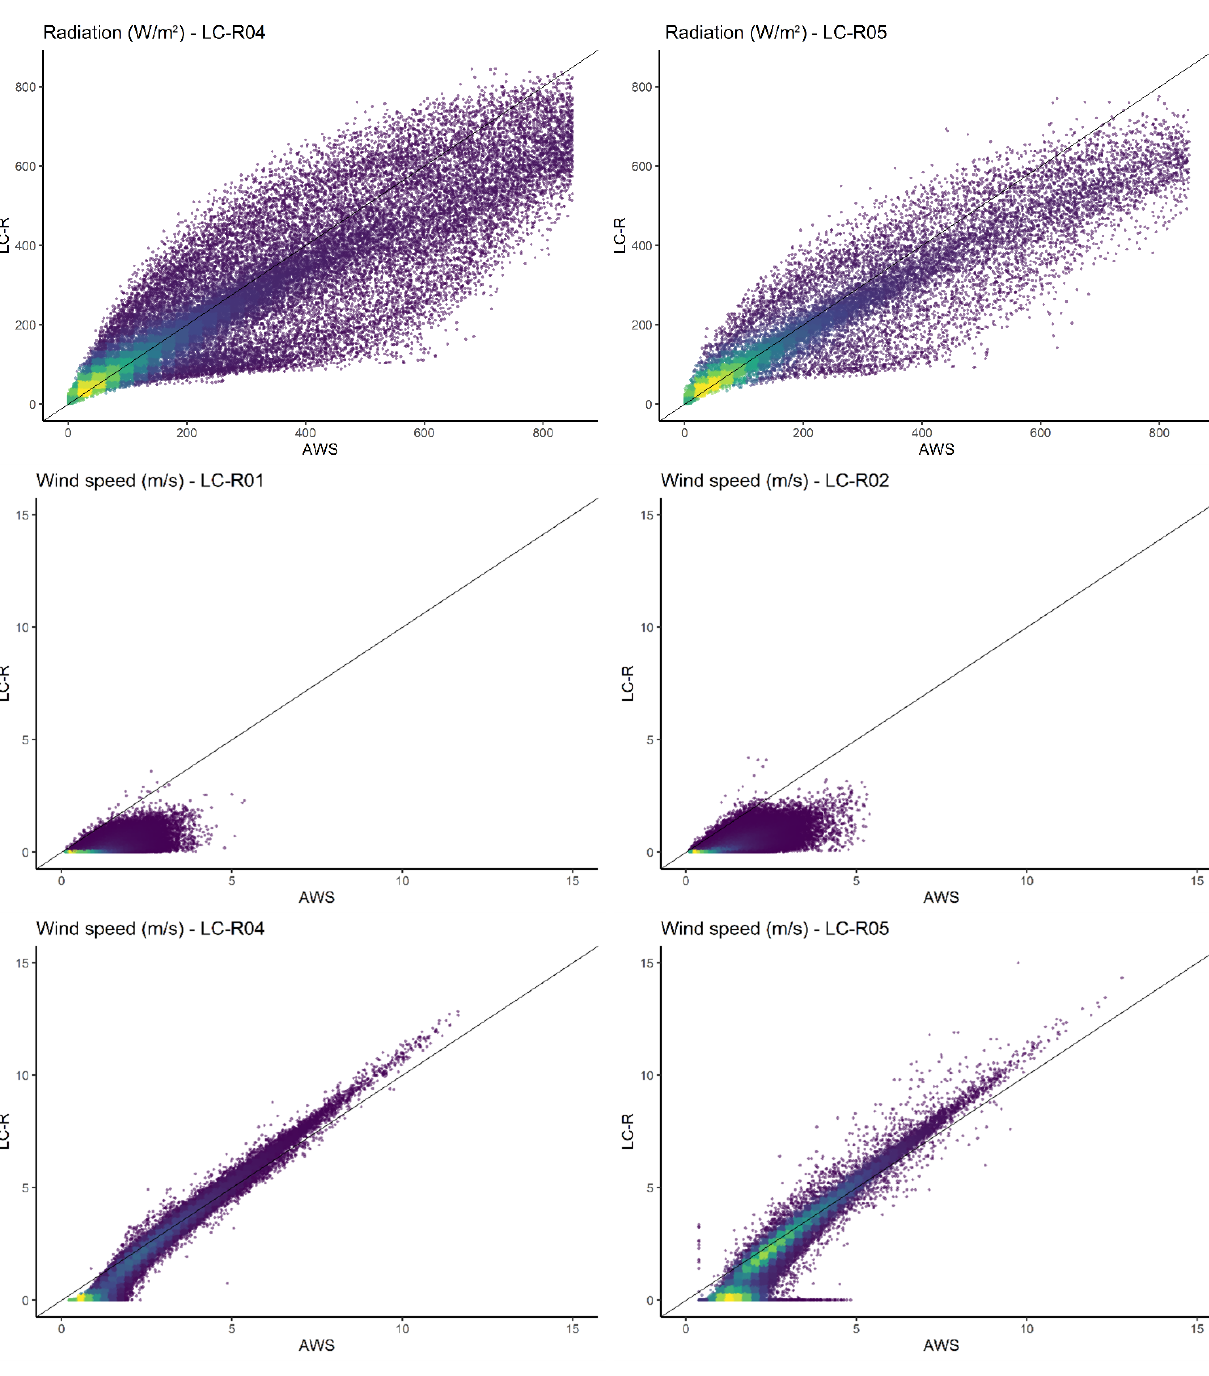
Figure C1. Scatterplots of LC-R versus AWS dew point temperature, humidity, radiation and wind speed for each reference station: LC- R01, LC-R02, LC-R04 and LC-R05. The identity line is shown in black. The colour scale indicates the density of observations, with yellow indicating the highest and purple indicating the lowest. The scatterplots include all measurements between the installation date of each LC-R and December 2021. For each variable, the same ranges are used on the x and y